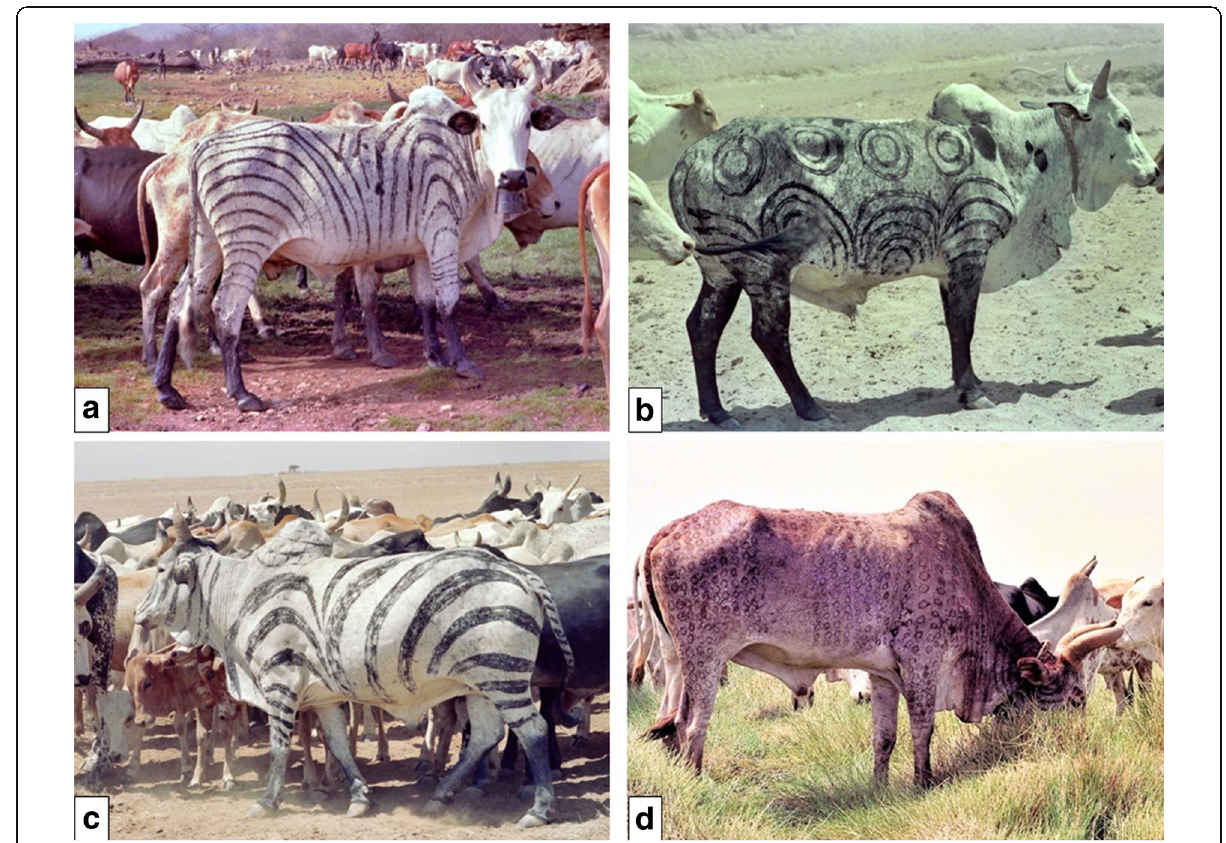
Fig. 3 Favourite oxen of various localities in North West Turkana: a , d Mogila Mountain, b Lokamarynyang (Ilemi Triangle), c Lotikipi